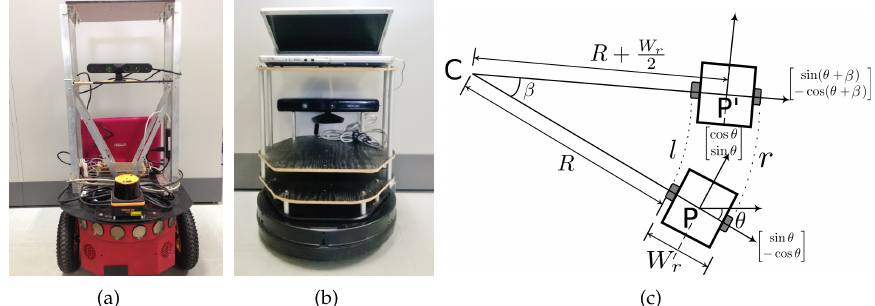
Figure 15. Robots used in the experiments. ( a ) Pioneer P3DX; ( b ) Kobuki Turtlebot; ( c ) Motion